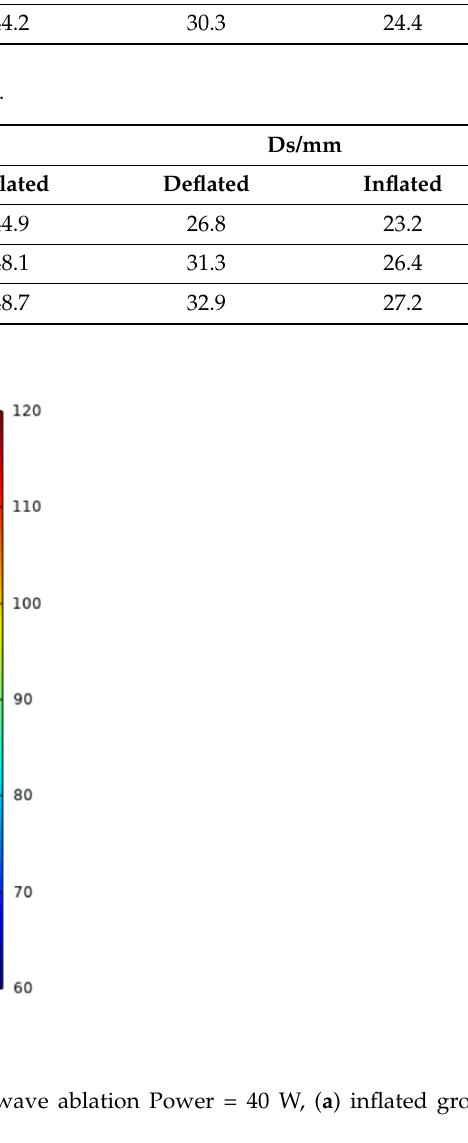
Figure 9. Thermal field distribution of microwave ablation (Power = 50 W, ( a ) inflated group; ( b ) deflated group ) .